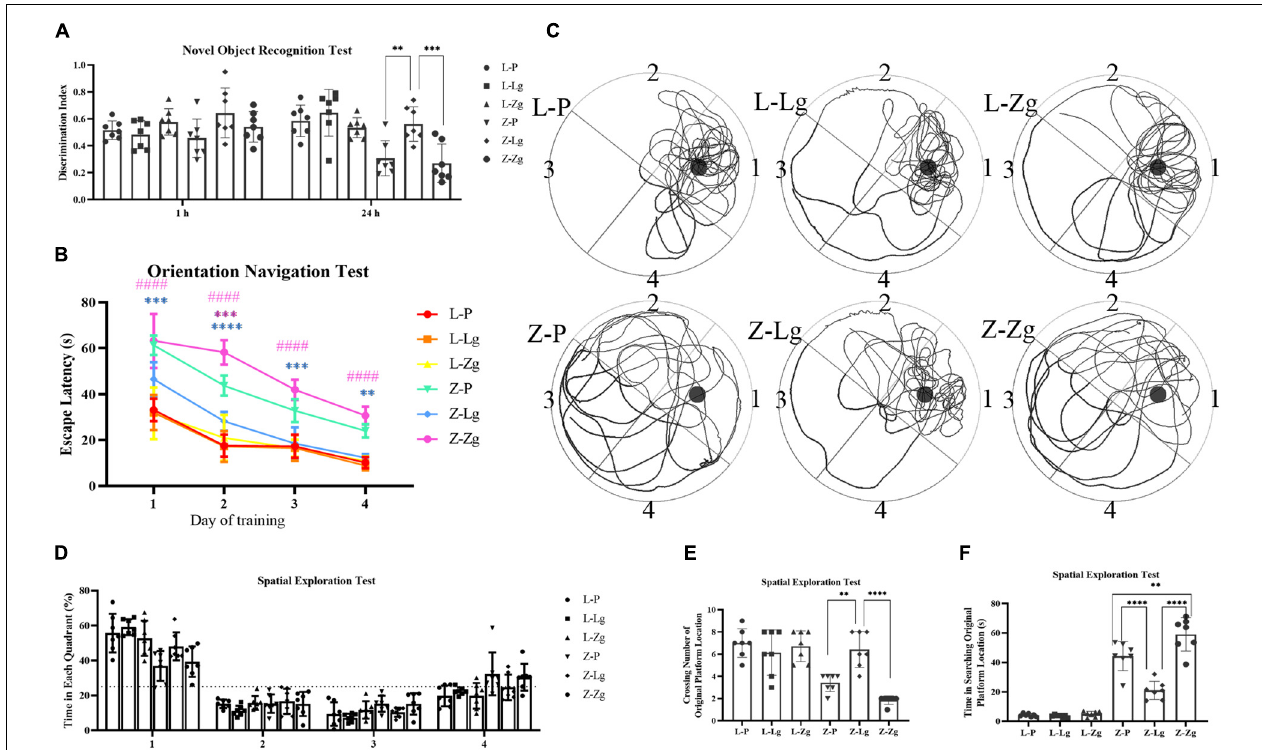
FIGURE 3 | GMT changes cognitive impairment in ZDF recipient rats. (A) Discrimination index in the new object recognition test [ F ( 5 , 36 ) = 7.603, P < 0.0001]. (B) The escape latency during a 4 days training course in the orientation navigation test [Time: F ( 3 , 18 ) = 171.7, P < 0.0001; Group: F ( 5 , 30 ) = 115.7, P < 0.0001]. (C–F) Representative swimming path (C) , time spent in each quadrant (%) (dotted line indicates that the average chance of entering each quadrant is 25%) (D) [ F ( 5 , 30 ) = 2.082, P =0.0955], crossing number of the original platform location (E) [ F ( 5 , 36 ) = 16.82, P < 0.0001] and time in searching original platform location (F) [ F ( 5 , 36 ) = 87.94, P < 0.0001] in the spatial exploration test. The small circle in (B) represents the original platform location, but the escape platform was removed in the spatial exploration test. Data are shown as mean ± SD ( n = 7 per group). ∗∗ P < 0.01, ∗∗∗ P < 0.001, ∗∗∗∗ P < 0.0001, compared with Z-P group; #### P < 0.0001, compared with Z-Lg group in (C) . ∗∗ P <0.01, ∗∗∗∗ P < in (A,D–F) . One-way or two-way ANOVA, followed by Tukey’s post-hoc